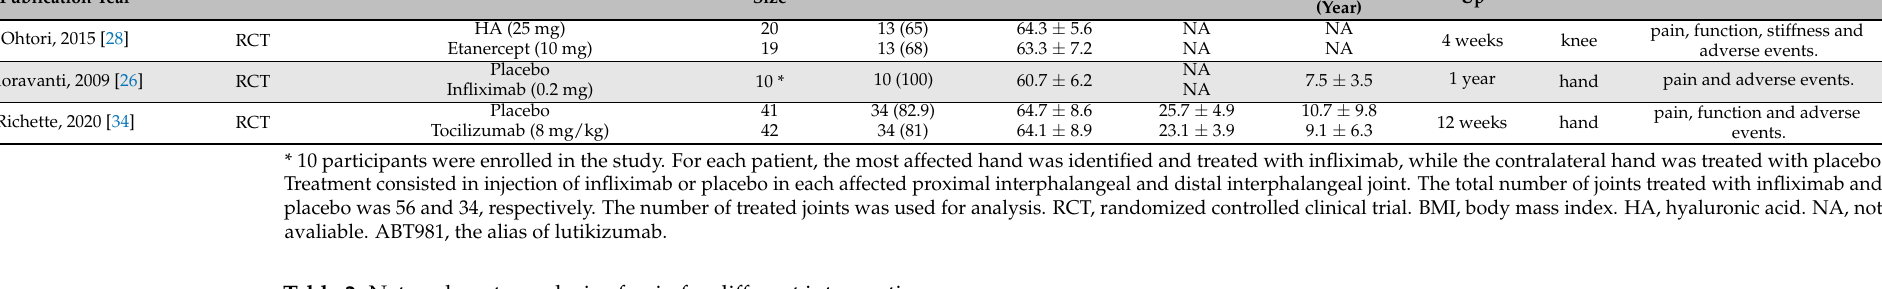
Table 2. Network meta-analysis of pain for different